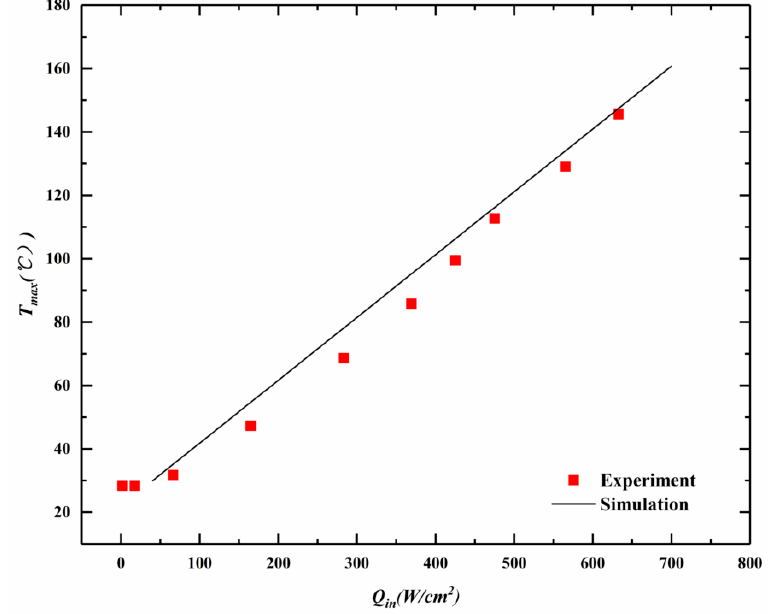
Figure 3. ( a ) Close-loop of the experimental test platform; ( b ) an IR camera was focused on the GaN power amplifier chips area (off working state).